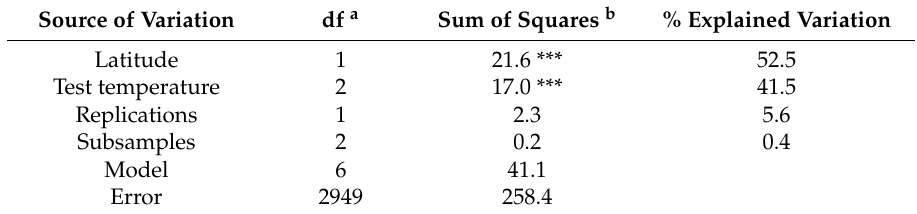
(Table 2). The freezing challenge temperature the plants were exposed to accounted for 41% of the variation; replications and subsamples accounted for 6% (Table 2). Even at the lowest treatment temperature of − 18 ◦ C, there were landraces with electrolyte leakage measures of 0.3 to 0.5, suggesting those landraces may be highly cold-tolerant (Figure S2). The regression analysis based on all of the data indicated a highly significant negative relationship of latitude and electrolyte leakage with an R 2 value of 0.14, ( p < 0.0001), indicating a general trend toward less damage (greater cold tolerance) in landraces from higher latitudes (Figure 3). A contour plot of electrolyte leakage superimposed on the world map clearly showed a relationship of greater freezing tolerance with increased latitude of origin (Figure 4). Table 2. Analysis of variance reporting significant effect of the geographic latitude of origin and the test temperature on freezing tolerance of 192 winter wheat ( Triticum aestivum L.) landrace accessions.